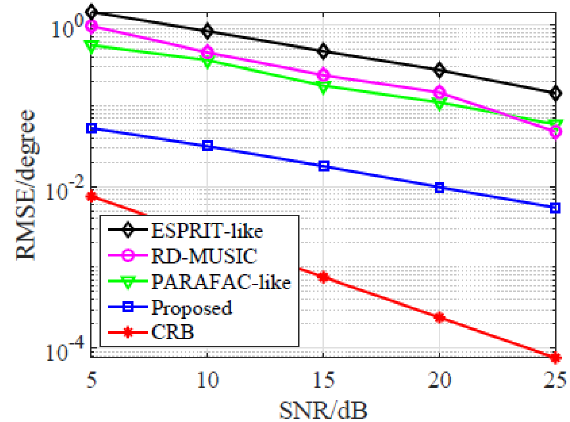
Figure 4. Average RMSE vs. SNR in Case II.